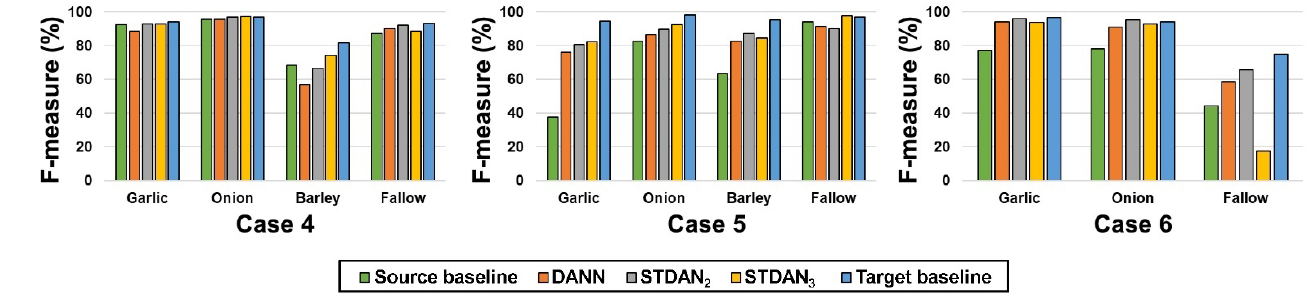
Figure 14. The class-wise F-measure of the five classification results for the three domain adaptation cases in Gyeongsang. cases in